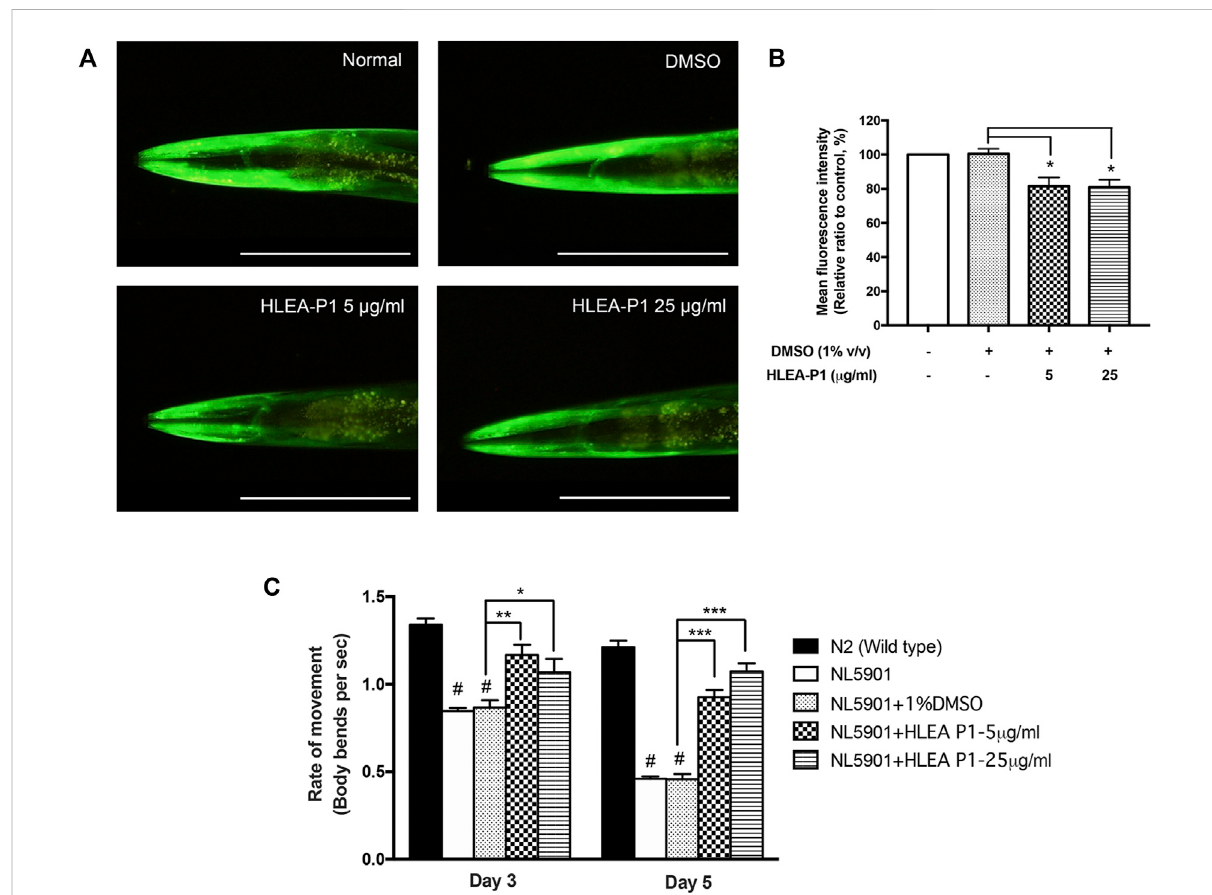
FIGURE 4 Effect of HLEA-P1 against α -synuclein aggregation and movement de fi cit in NL5901 C. elegans expressing α -synuclein. (A) Representative of YFP-tagged α -synuclein expression in body wall muscle cells of NL5901 strain. (B) Graphical representation for relative fl uorescent intensity of YFP expression. (C) Graphical representation of the rate of movement of C. elegans with HLEA-P1 treatment. The data are presented as mean ± SD ( n = 30, number of animals). The hash (#) indicates a signi fi cant difference between N2 wild type and NL5901 worms ( p < .05). The asterisk (*) indicates signi fi cant differences between untreated group (DMSO) and HLEA-P1-treated group, * p < .05, ** p < .01, *** p < .001. Scale bar is 200 μ